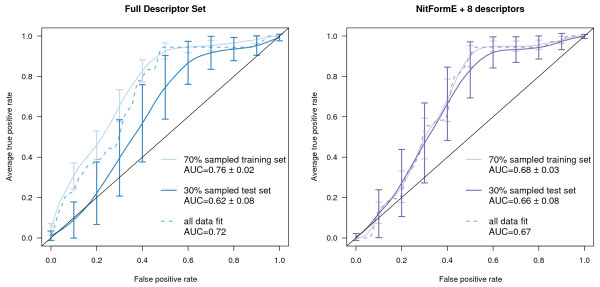
Averaged ROC curves for Set A aryl-amine PLS models. The plot on the left is for the model built with a full descriptor set and the plot on the right is for a limited descriptor set. The left plot shows the averaged (identical false positive values) ROC curves for the test (dark line) and training (lighter line) sets of 100 PLS models built on a random 70% sample of the Set A aryl-amine data (MW < 250 g/mol) and the performance of a PLS model built on all of the data as a dashed line with all non-zero-variance descriptors. The right plot uses only 9 descriptors including nitrenium formation energy.